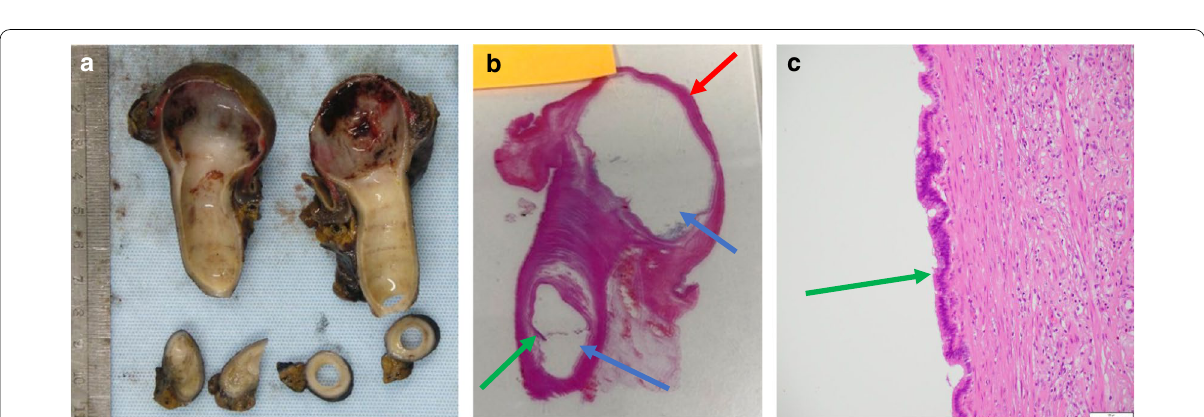
Fig. 4 Macroscopic and microscopic histopathological tissue from proximal appendix: a illustrates the gross histological appendiceal specimen and b histological section showing a low-grade appendiceal mucinous neoplasm which involves the entire length of the appendix. The lesion undermines colonic mucosa at the caecal pole (red arrow) demonstrating ulceration and granulation tissue. Mucoid material can be seen extruding from the appendix (blue arrows), and mucinous goblet cells can be seen within low-grade neoplastic epithelium (green arrows) ( b , c